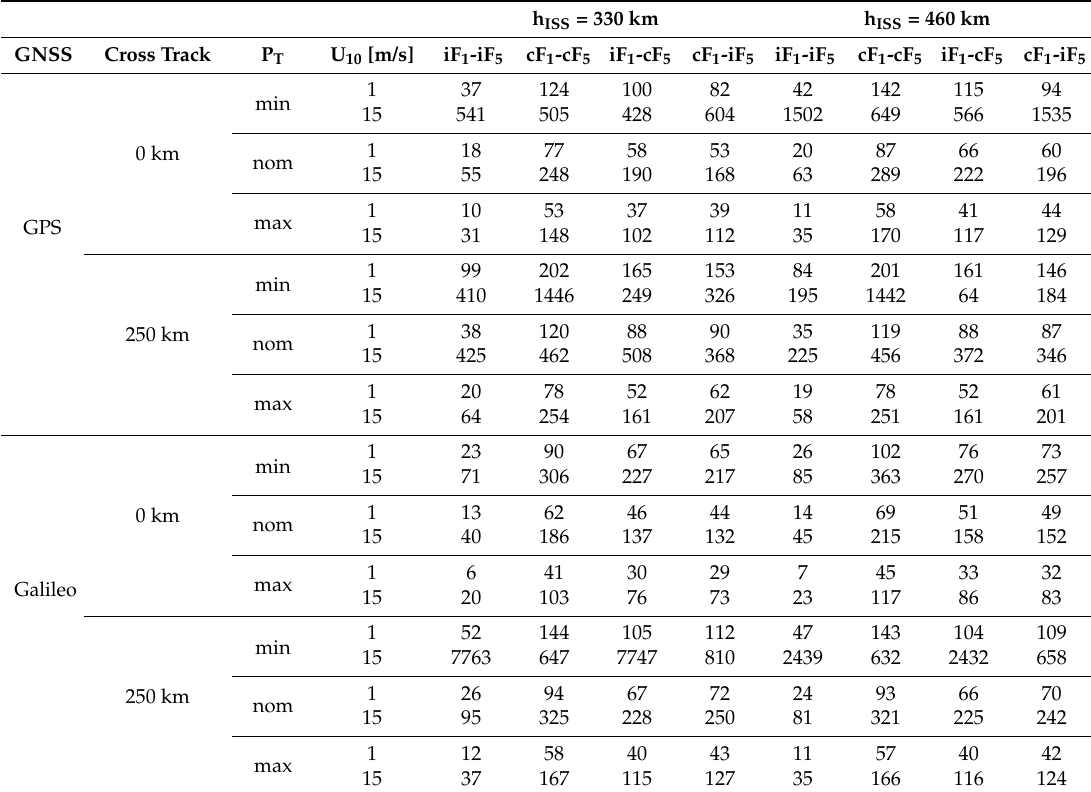
Table 4. GEROS-ISS Performance Summary [cm rms ]: GPS and Galileo constellations; minimum, observables, and h ISS = 330 km and 460 km, and for cross-track distances of 0 and 250